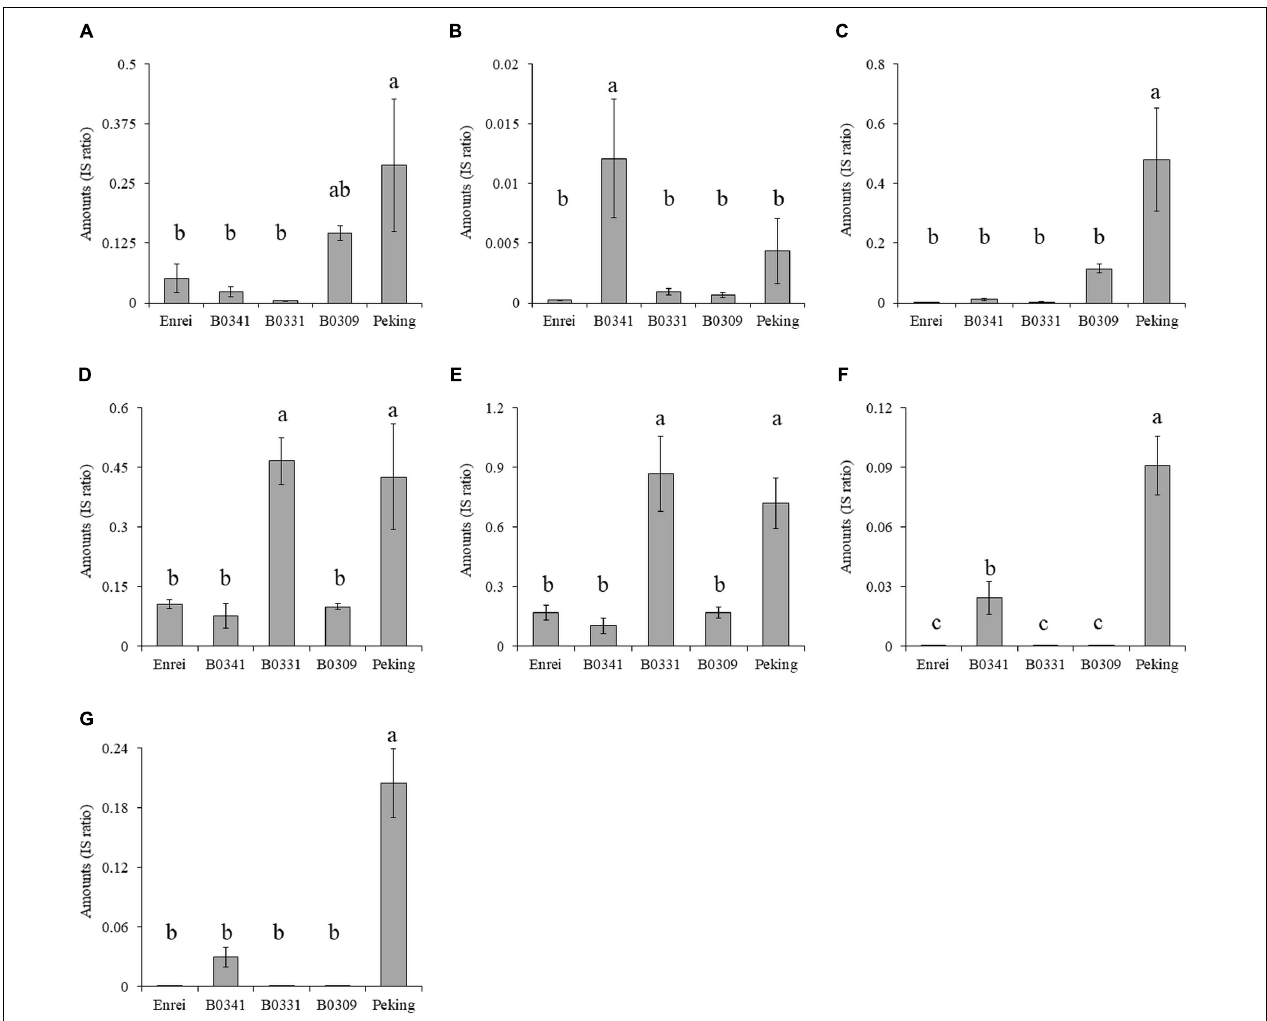
FIGURE 5 | The amounts of metabolites (A–G) in three chromosome segment substitution lines (B0341, B0331 and B0309), Enrei and Peking. Different letters indicate significant differences between lines (Tukey’s test, n = 3, P < 0.05). B0341, B0331 and B0309 possess the Peking-genomic segment tagged by the markers #89, #92 and #318, respectively.